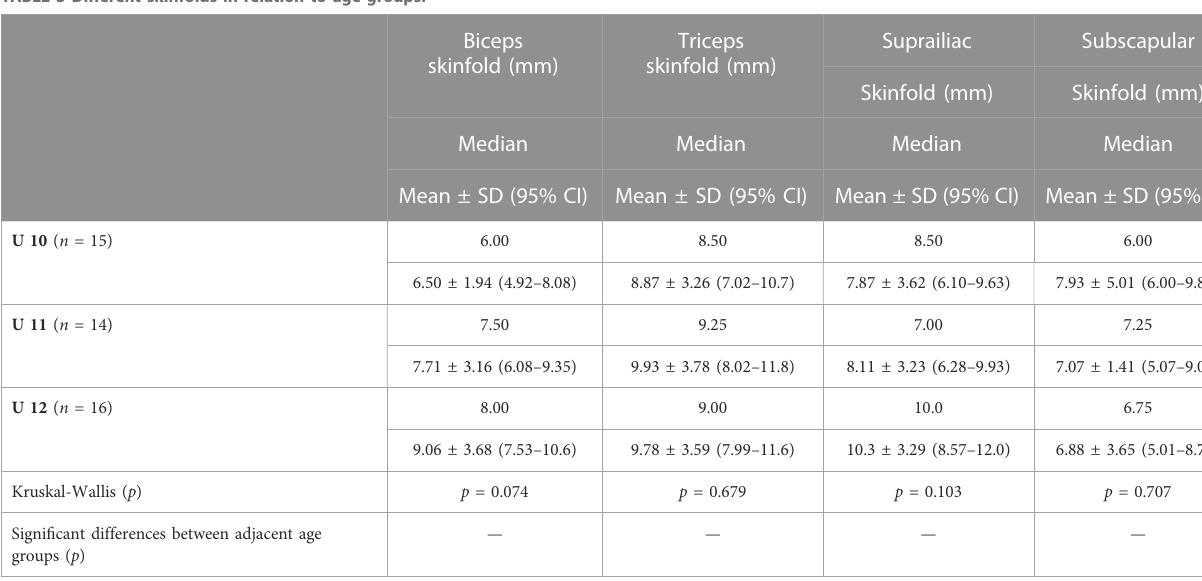
TABLE 3 Different skinfolds in relation to age